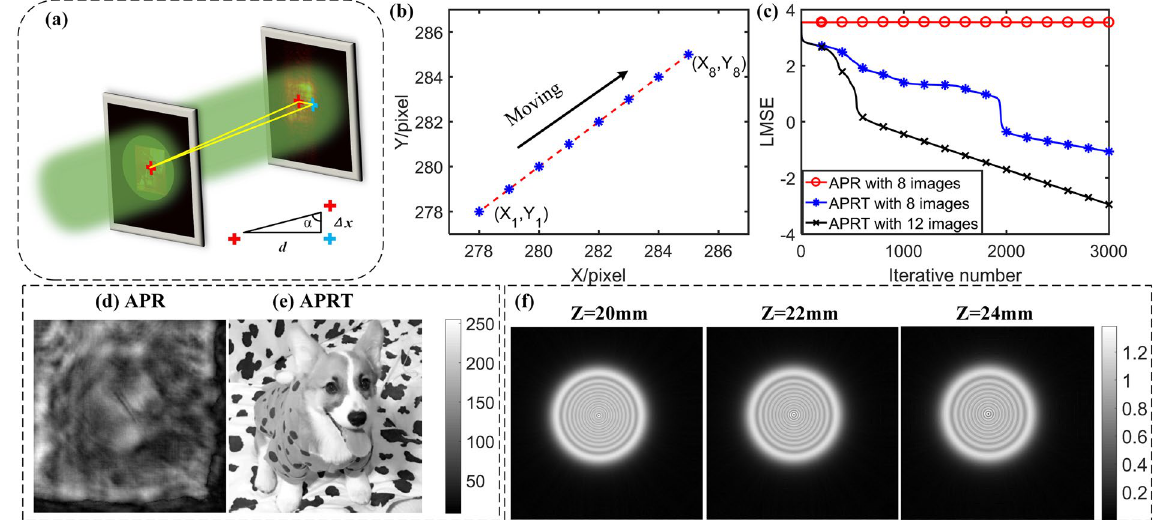
Figure 3. The calibration of tilt illumination for APR algorithm: ( a ) The schematic of cross-correlation calibration. ( b ) The movement of the peak position of cross-correlation. ( c ) The LMSE curve in assigned circumstances. ( d ) and ( e ) denote the uncalibrated and calibrated reconstructed amplitude. ( f ) The diffraction disc of incident light in Z n = 20 mm, 22 mm and 24 mm.